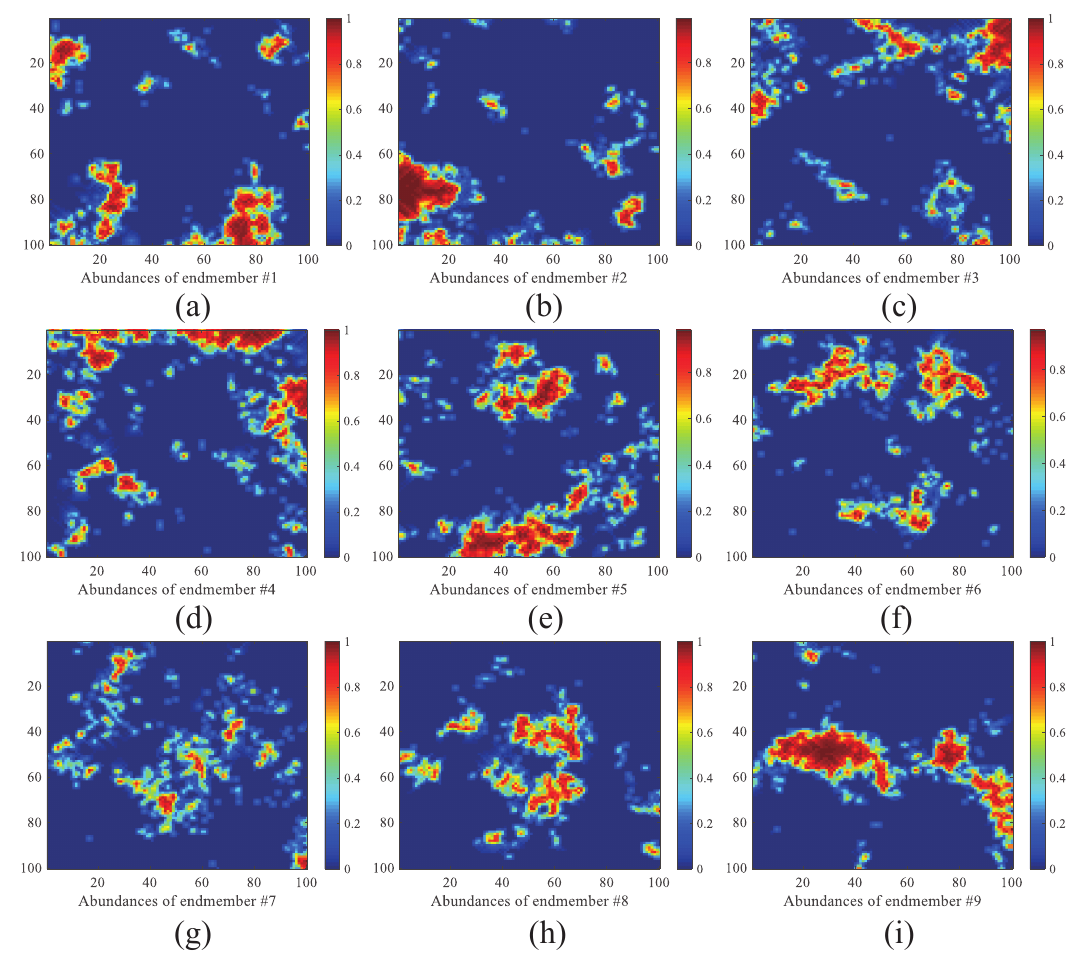
Figure 5. True abundance maps of five endmembers in data 2. ( a ) True abundance map of endmember 1. ( b ) True abundance map of endmember 2. ( c ) True abundance map of endmember 3. ( d ) True abundance map of endmember 4. ( e ) True abundance map of endmember 5. ( f ) True abundance map of endmember 6. ( g ) True abundance map of endmember 7. ( h ) True abundance map of endmember 8. ( i ) True abundance map of endmember